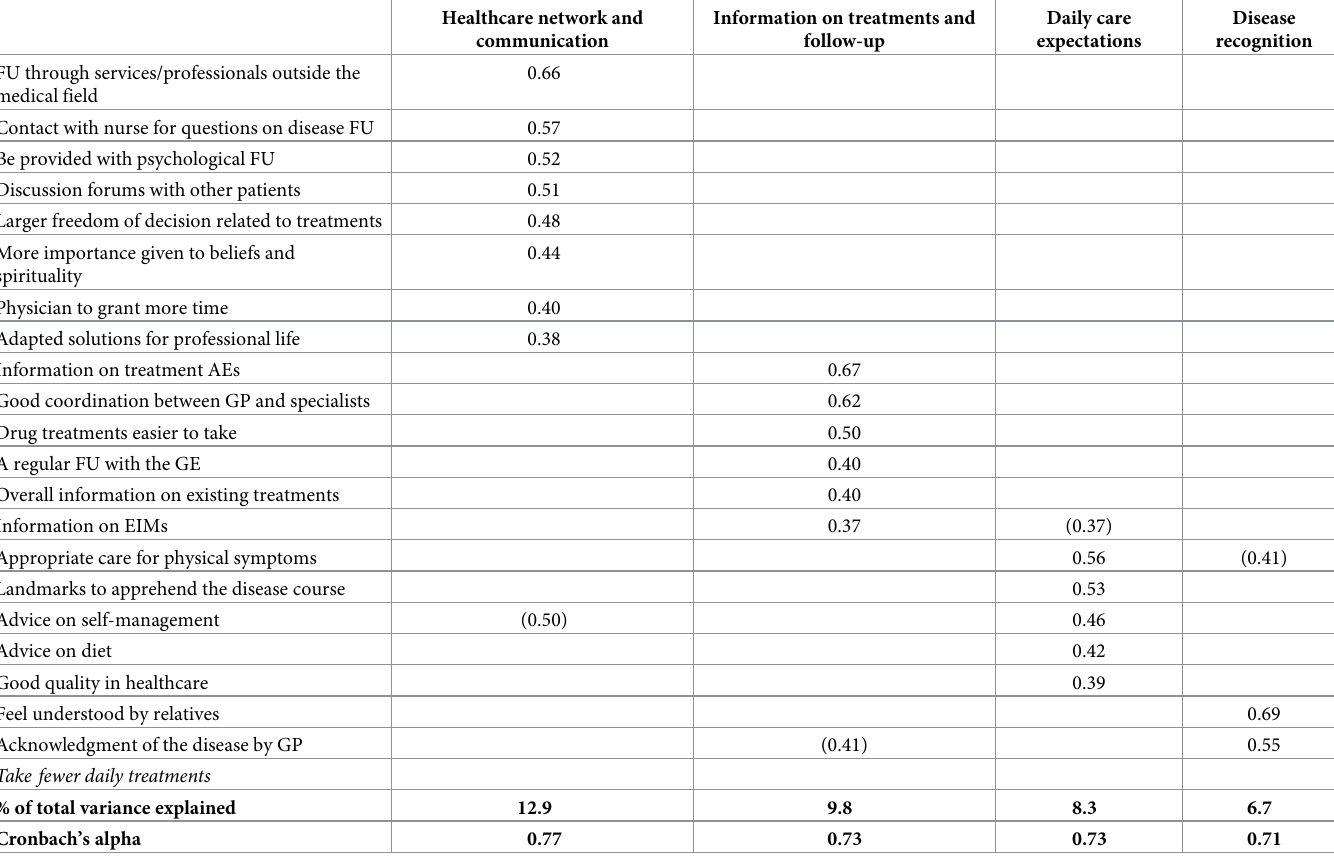
Table 2. Results of the rotated factor matrix performed on data from the SIBDC patient survey. Healthcare network and